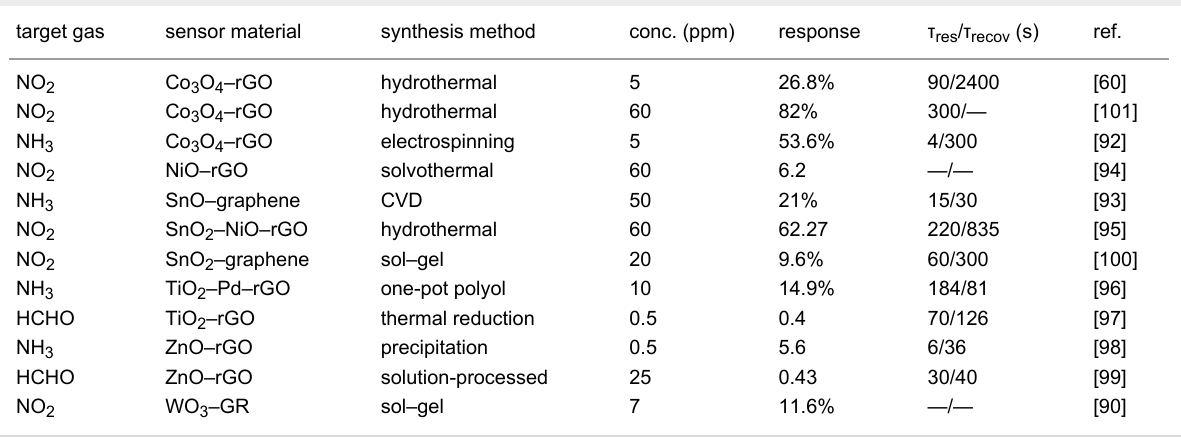
Table 4: Gas-sensing performance of graphene/metal-oxide sensors at room temperature. target gas